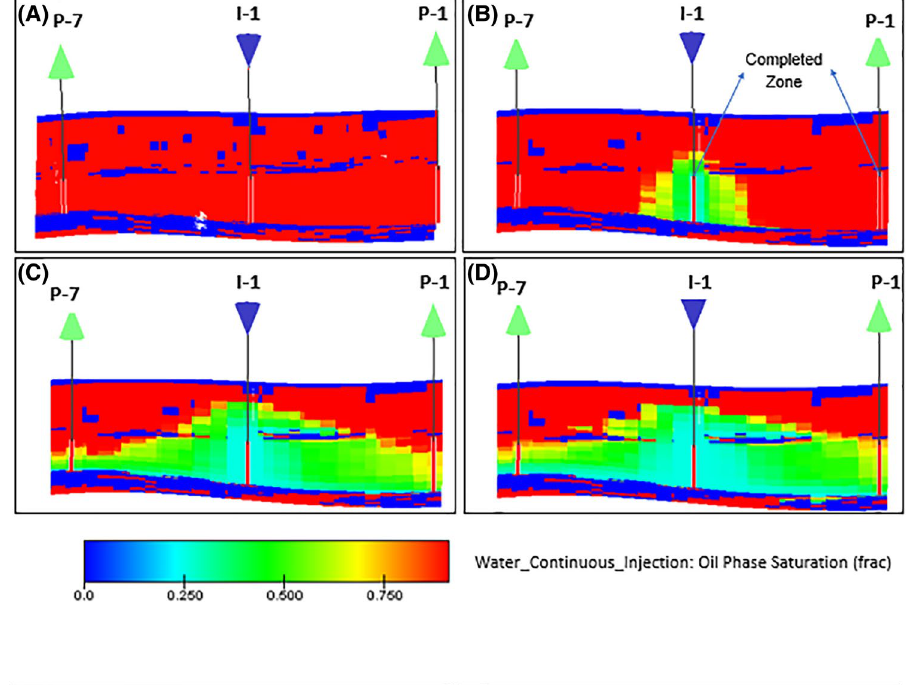
Fig. 9 Water saturation distribu- tion a 6 months; b 2 years c 5 years and d 10